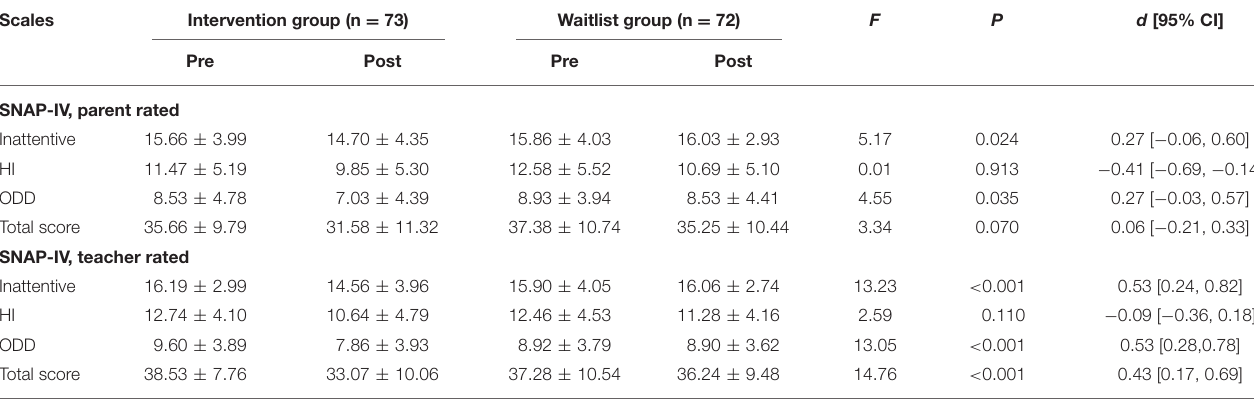
TABLE 3 | Effects of GEF-OPT by SNAP-IV scales. Scales Intervention group (n = 73) Waitlist group (n = 72) F P